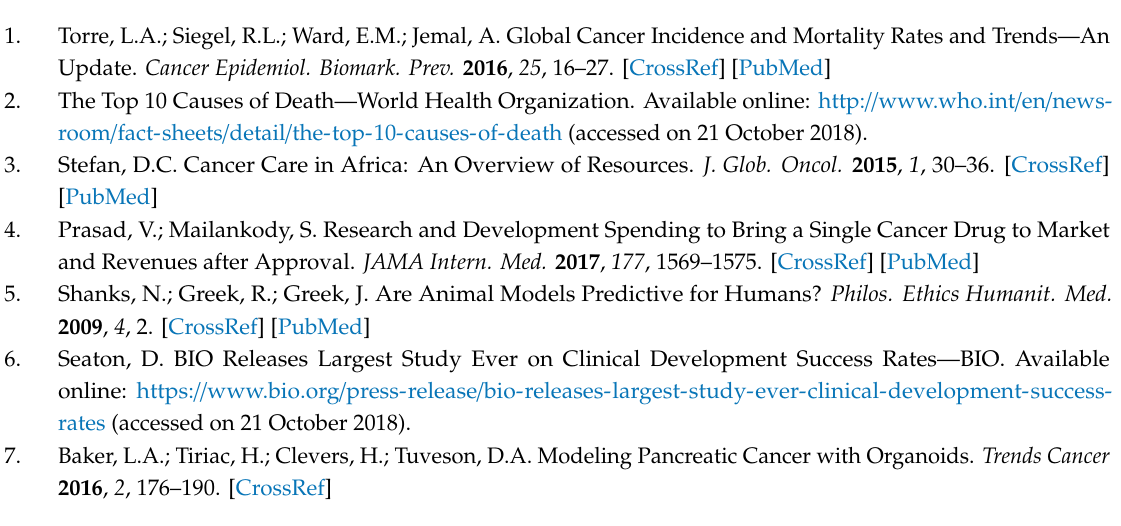
image of Sytox Green death stain of the tissue. Orange arrows indicate locations of intentional crush lesions that act as positive controls for tissue death. ( D ) Hoechst and Sytox Green fluorescent intensity data across the surface of the tissue (marked by white-dashed rectangles in ( B ) and ( C ). Black-dashed lines indicate the location of threads during the